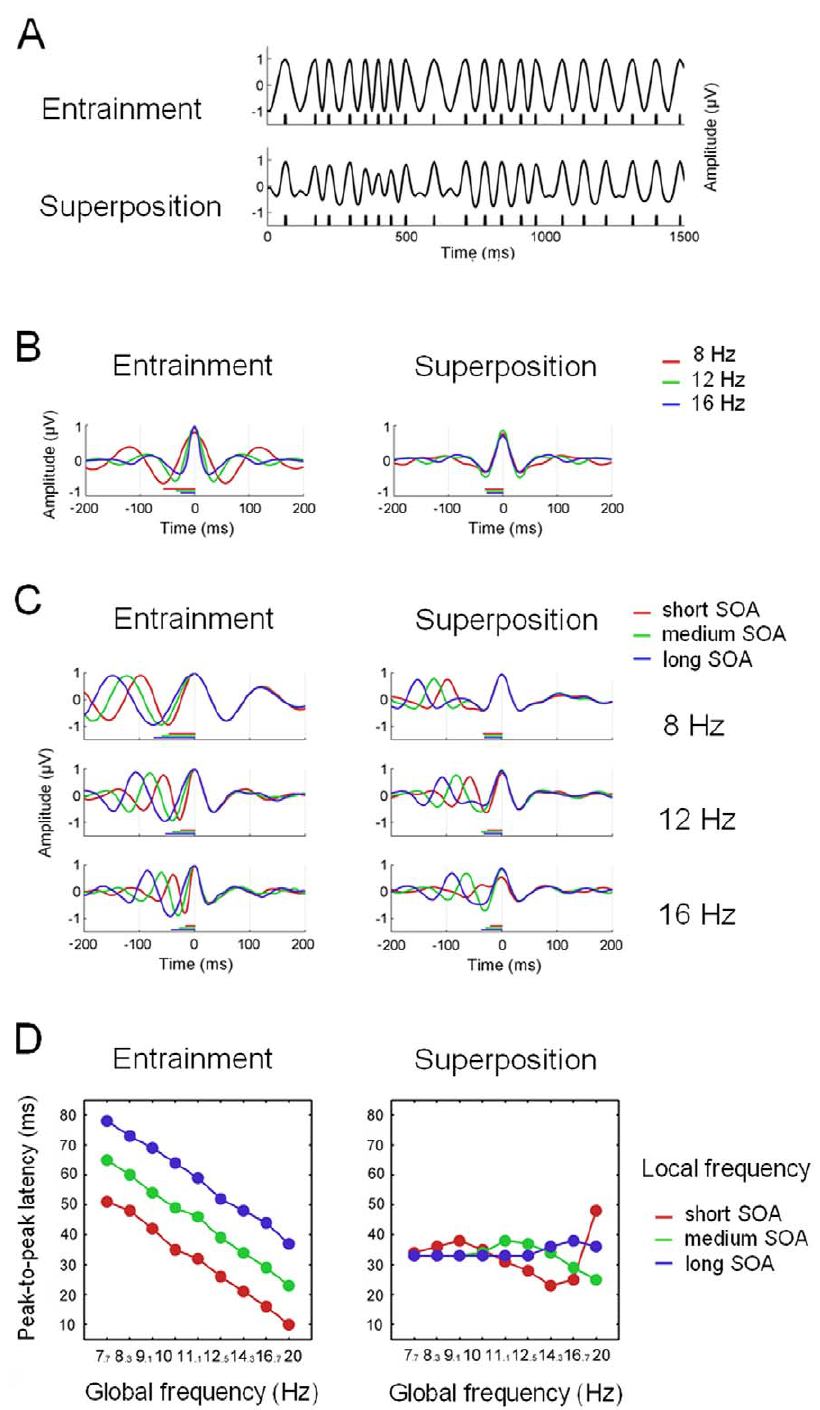
Figure 9. Simulation of the influence of both global and local stimulation frequency on the shape of the average ERP. A , Example of the response elicited by a jittered stimulation train in both the oscillatory entrainment and the superposition scenarios. B , Average waveforms for different stimulation frequencies. The solid bars along the x axis reflect the peak-to-peak latency. C , Average waveforms for trials grouped by their immediately past SOA. D , Variation in the peak-to-peak latency in both scenarios, as a function of both mean stimulation rate and local frequency.